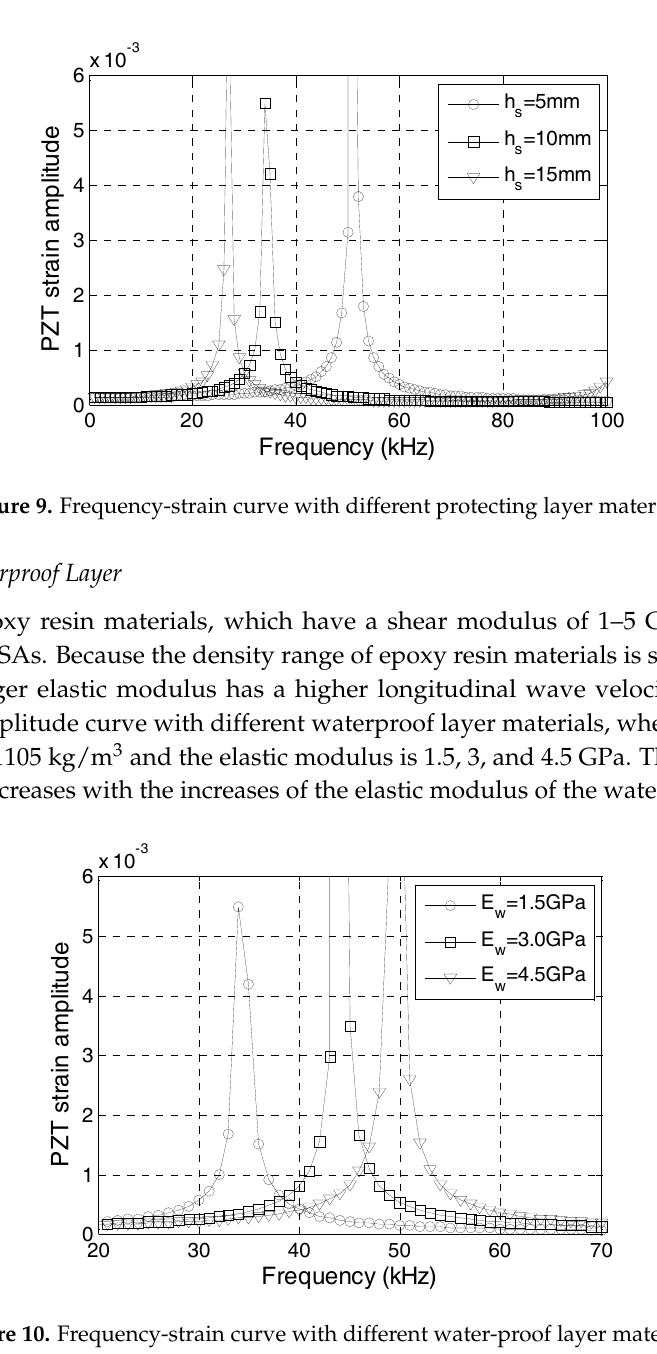
Figure 10. Frequency-strain curve with different water-proof layer materials.